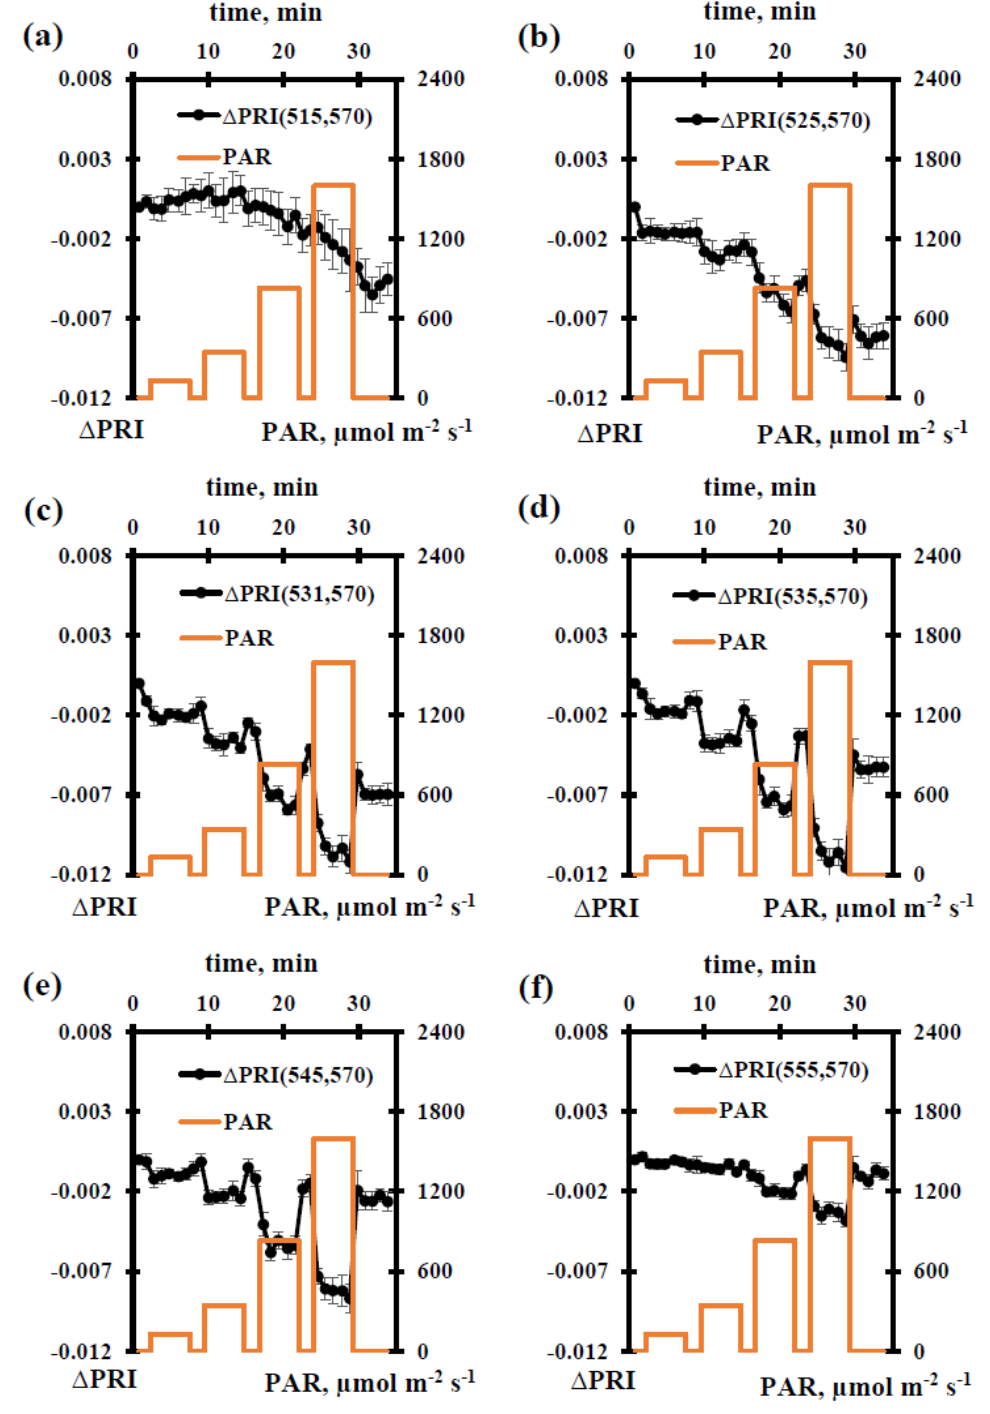
Figure 3. Averaged light curves for the ∆ PRIs, which were calculated on the basis of the intensities of the actinic light at different wavelengths, including ∆ PRI(515,570) (a) , ∆ PRI(525,570) (b) , ∆ PRI(531,570) (c) , ∆ PRI(535,570) (d) , ∆ PRI(545,570) (e) , and ∆ PRI(555,570) (f) in pea leaves ( n = 6). PAR was the intensity of the actinic light. The ∆ PRIs were measured every minute (every GYL pulse).